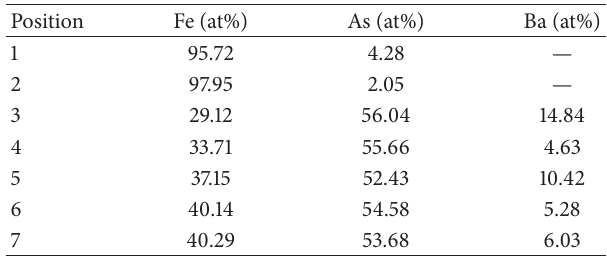
Table 1: EDX analysis relative to the white cross markers reported in Figure